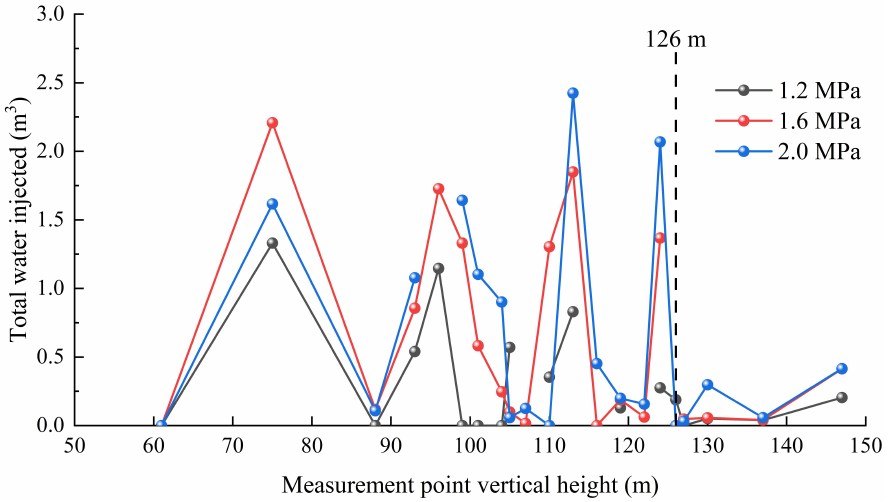
Figure 11. Total water injected at different measuring points in T1.